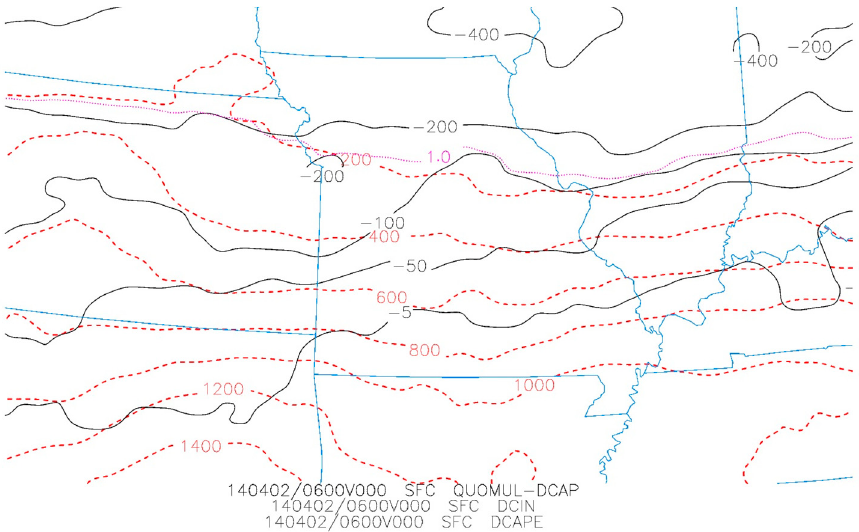
Figure 6. Example of a plan-view analysis of DCIN (J kg − 1 ; black-solid lines), DCAPE (J kg − 1 ; red-dashed lines), and the |DCIN|/|DCAPE| ratio equal to 1.0 in purple dotted lines. Taken from http://weather.missouri.edu/dcin.